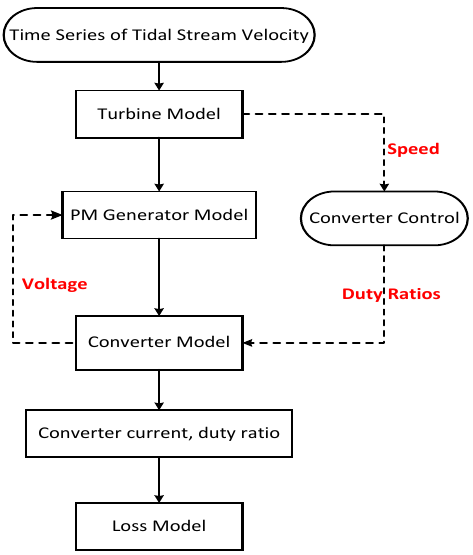
Figure 8. Calculating converter currents and duty ratios for loss calculation in IGBT modules; image adapted from